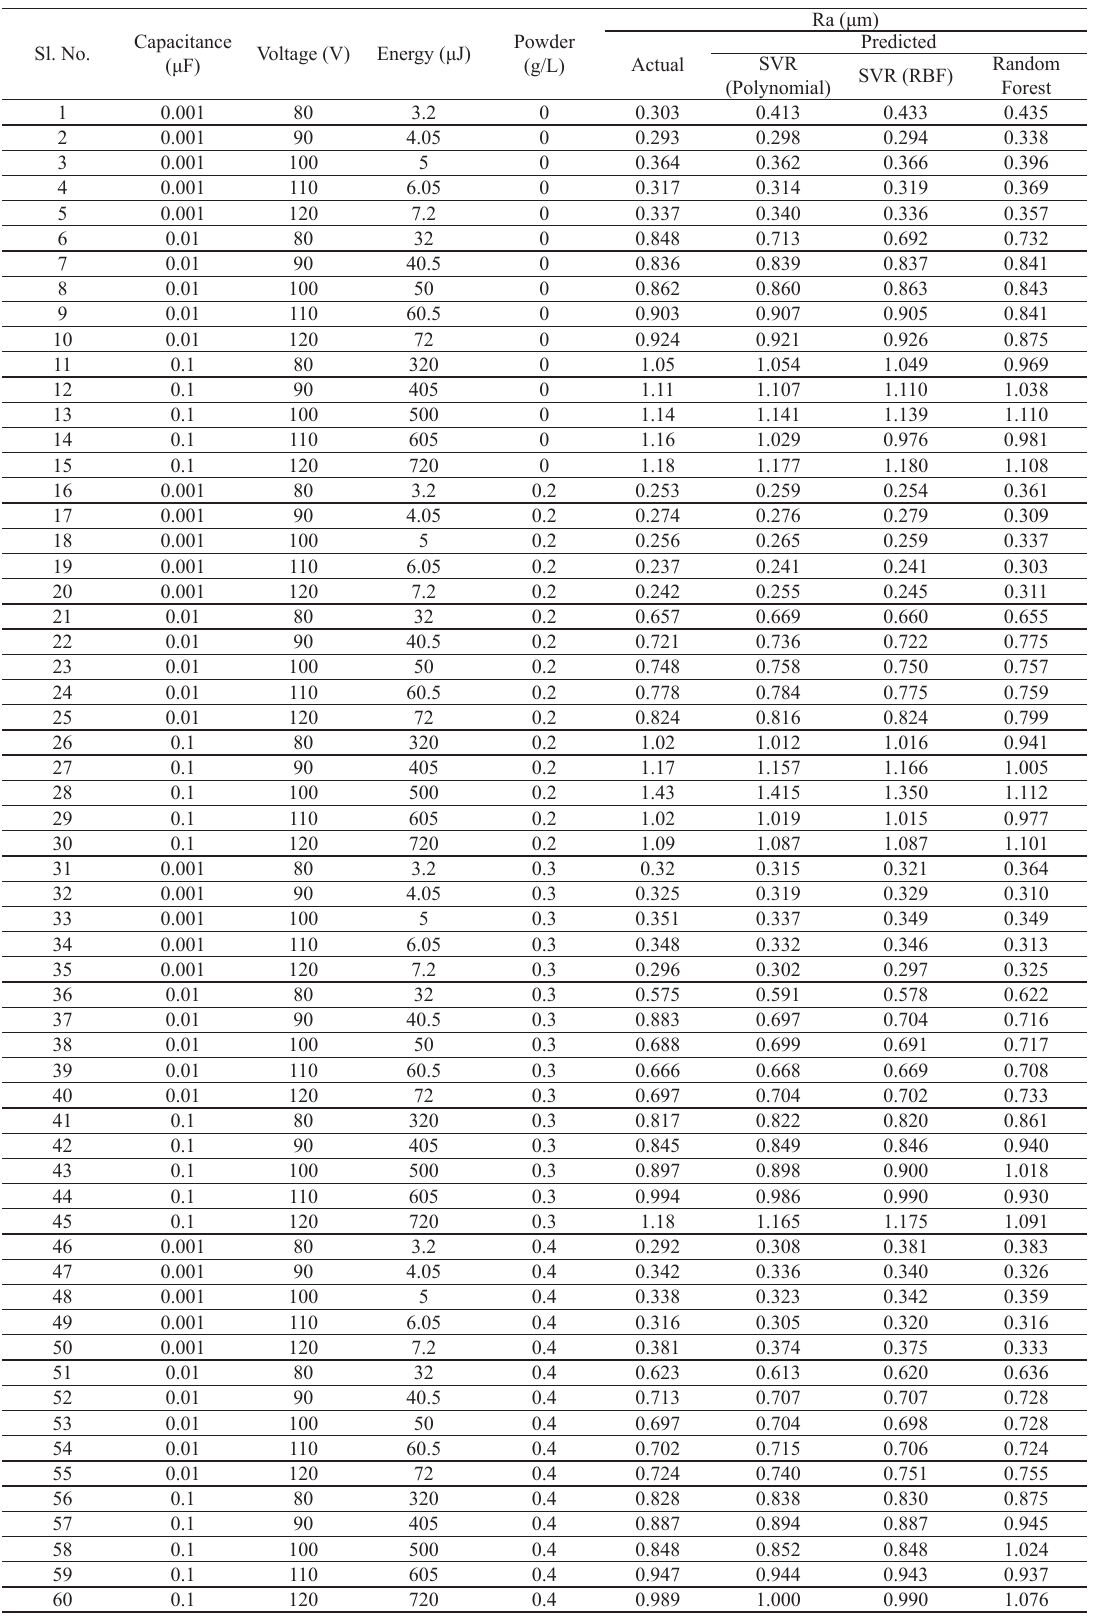
Table 2. Experimental and Predicted Surface Roughness for various. Sl.